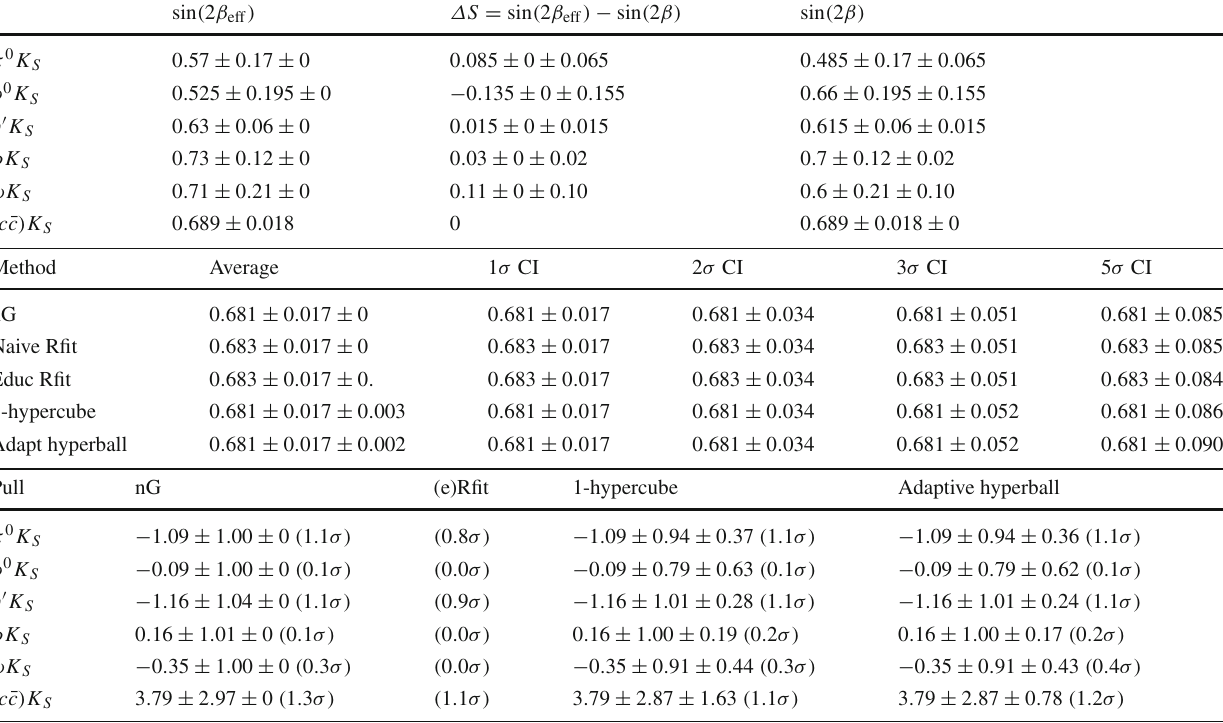
Table 11 Top: symmetrized determinations of sin ( 2 β eff ) from various penguin b → q ¯ qs modes and from charmonia modes [36], and estimate within QCD factorization of the correction from penguin pollution in the Standard Model (symmetrized range quoted in Table 1 in Ref. [63]). We neglect any penguin pollution in the case of the charmonium extrac- tion of sin ( 2 β) . Middle: averages according to the various methods, and